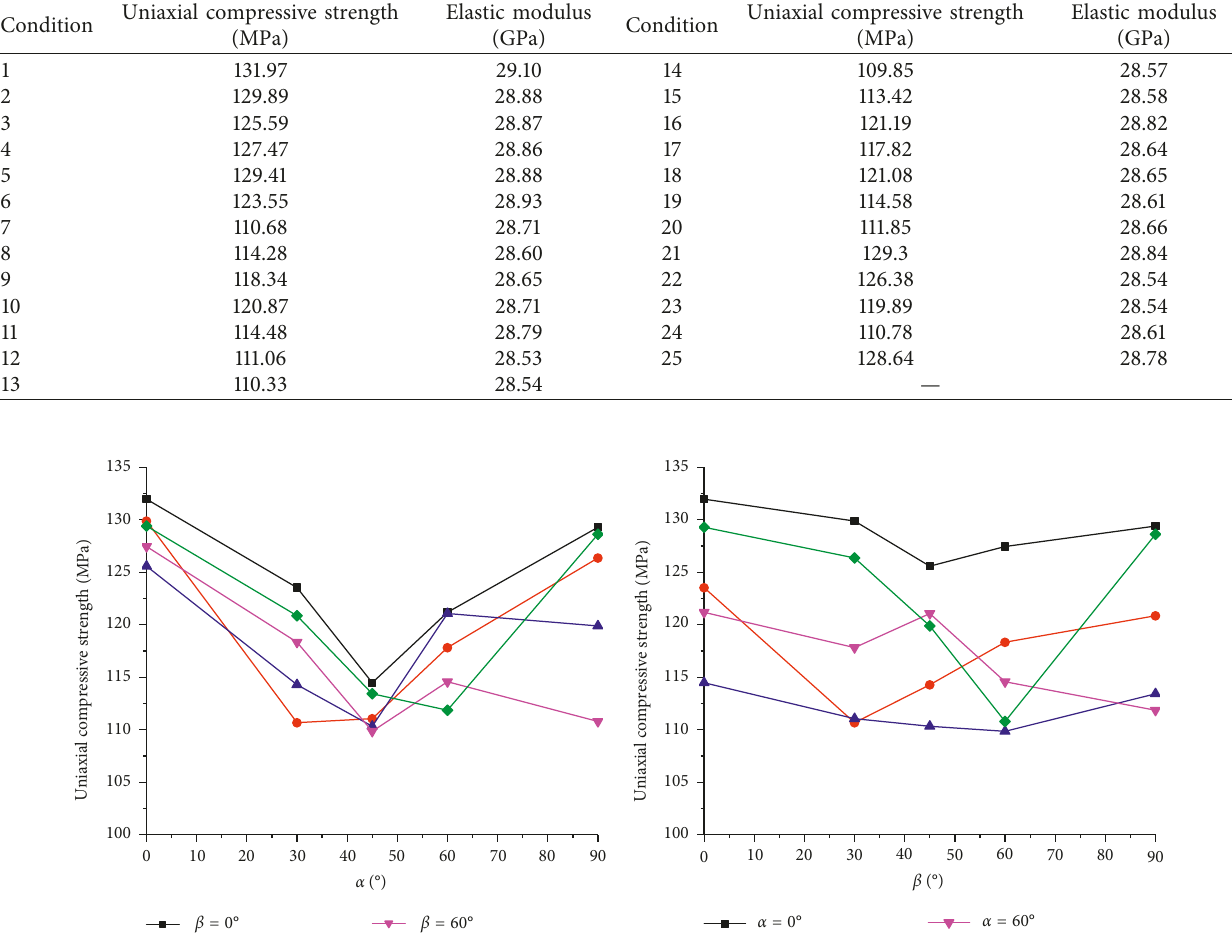
Table 4: Simulation test results.